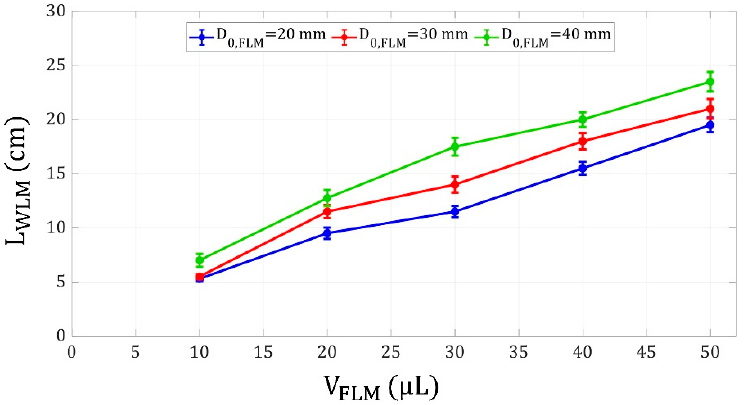
11 of 17 Figure 8. WLM shooting distance versus WLM volume for WLM initial distances of 0, 10, and 20 mm from the electromagnet, FLM volume and initial distance of 30 μ L and 30 mm from the electro- magnet, respectively, and the coil current of 3 A.